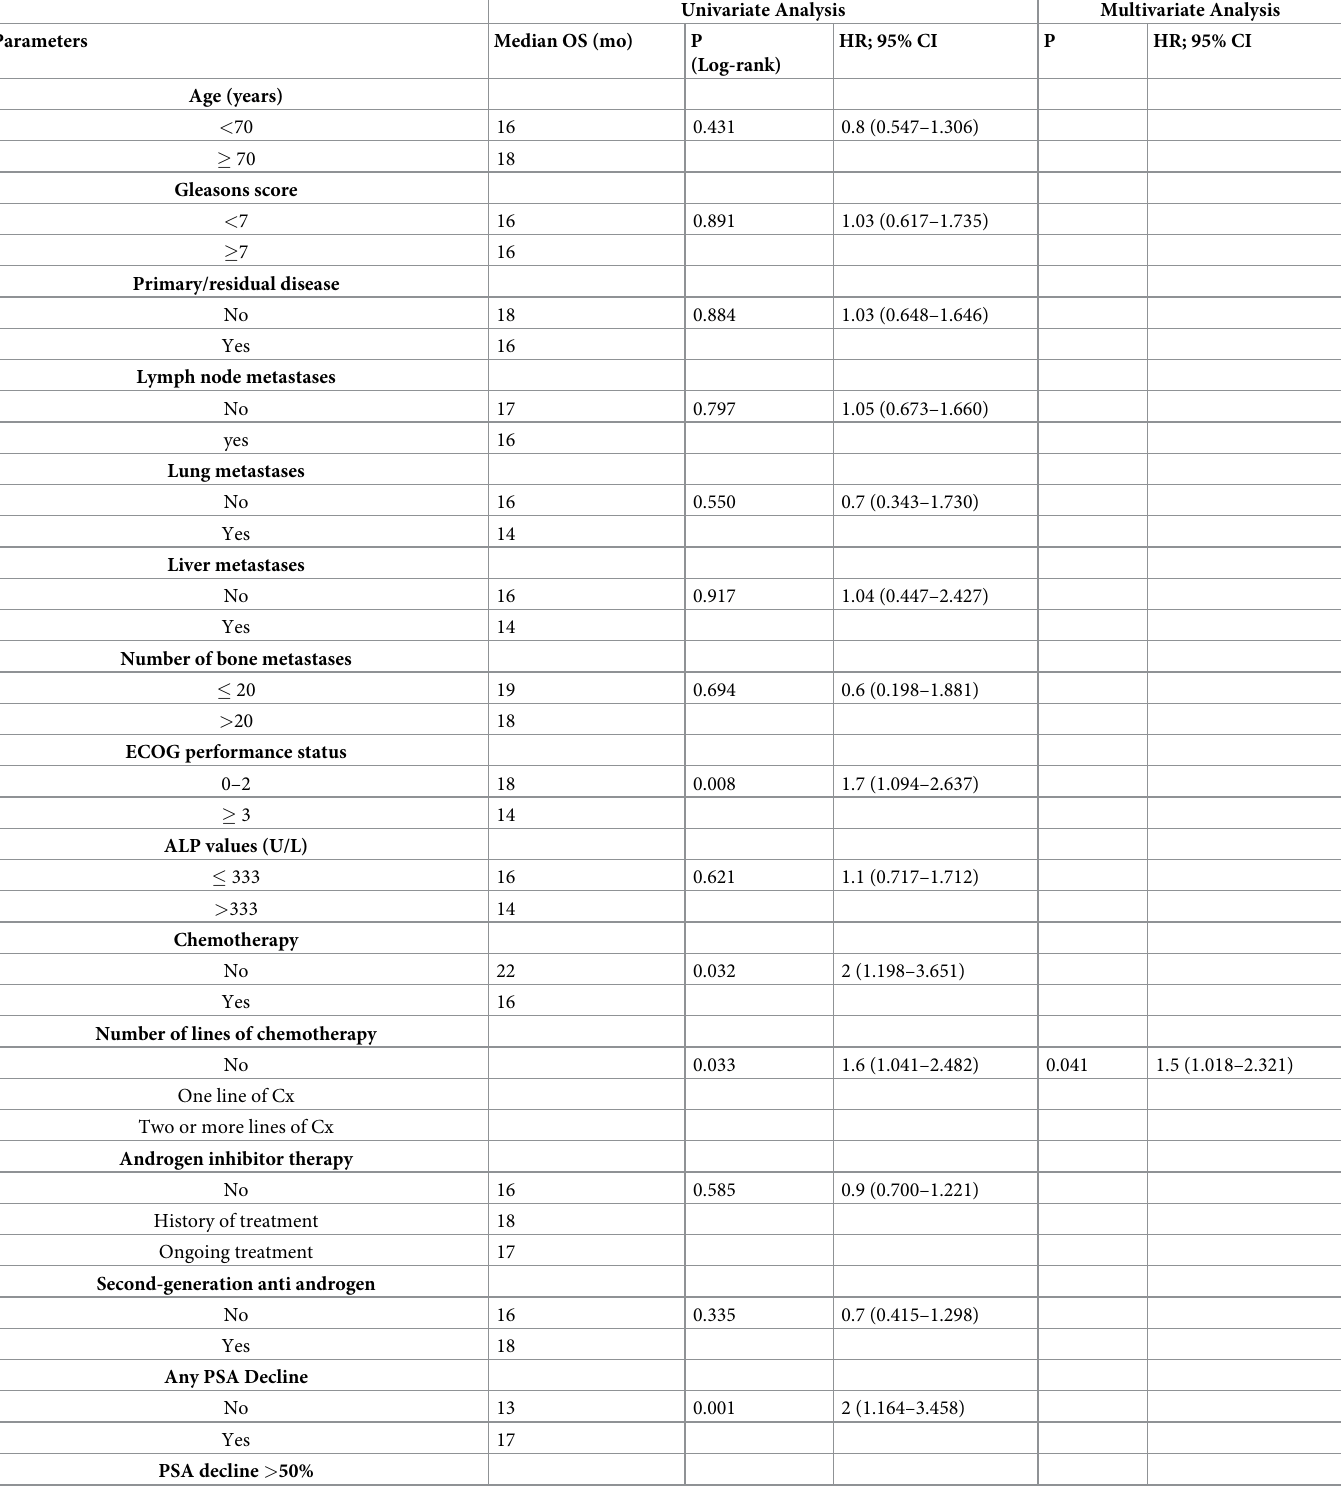
Table 3. Univariate and multivariate Cox-proportional hazard regression of factors associated with overall